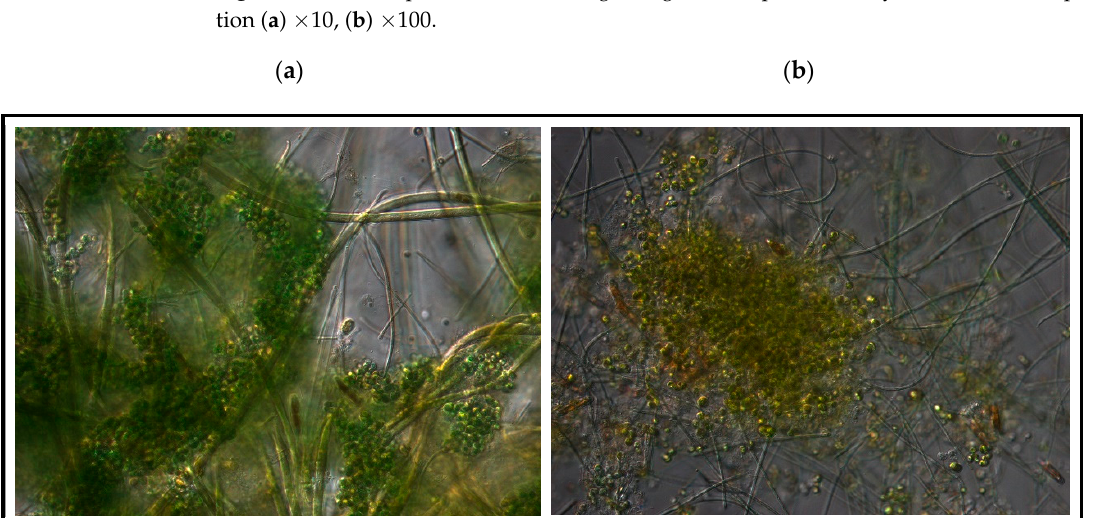
Figure 9. Characteristic views with microscopic magnification ×100 of microalgal-bacterial consortia produced after ( a ) 15 and ( b ) 30 days of H-PBR operation.